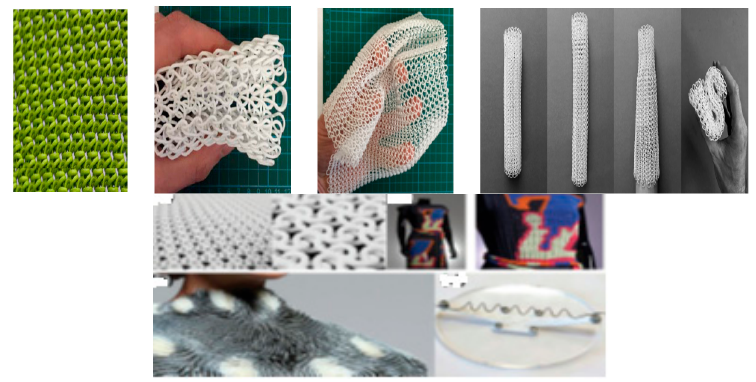
Figure 11. Samples of the 3D printed textile structures and clothes [57,58,66,100]